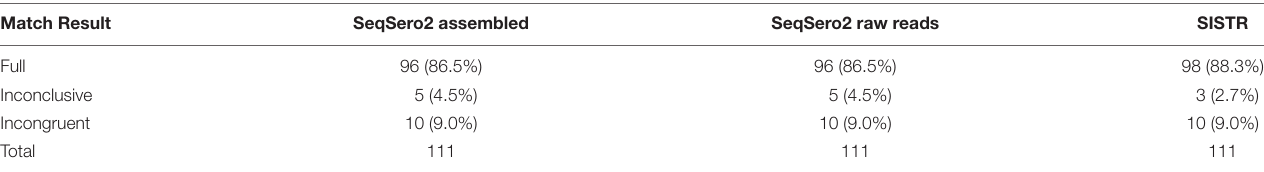
TABLE 4 | Performance of in silico tools for detecting Salmonella